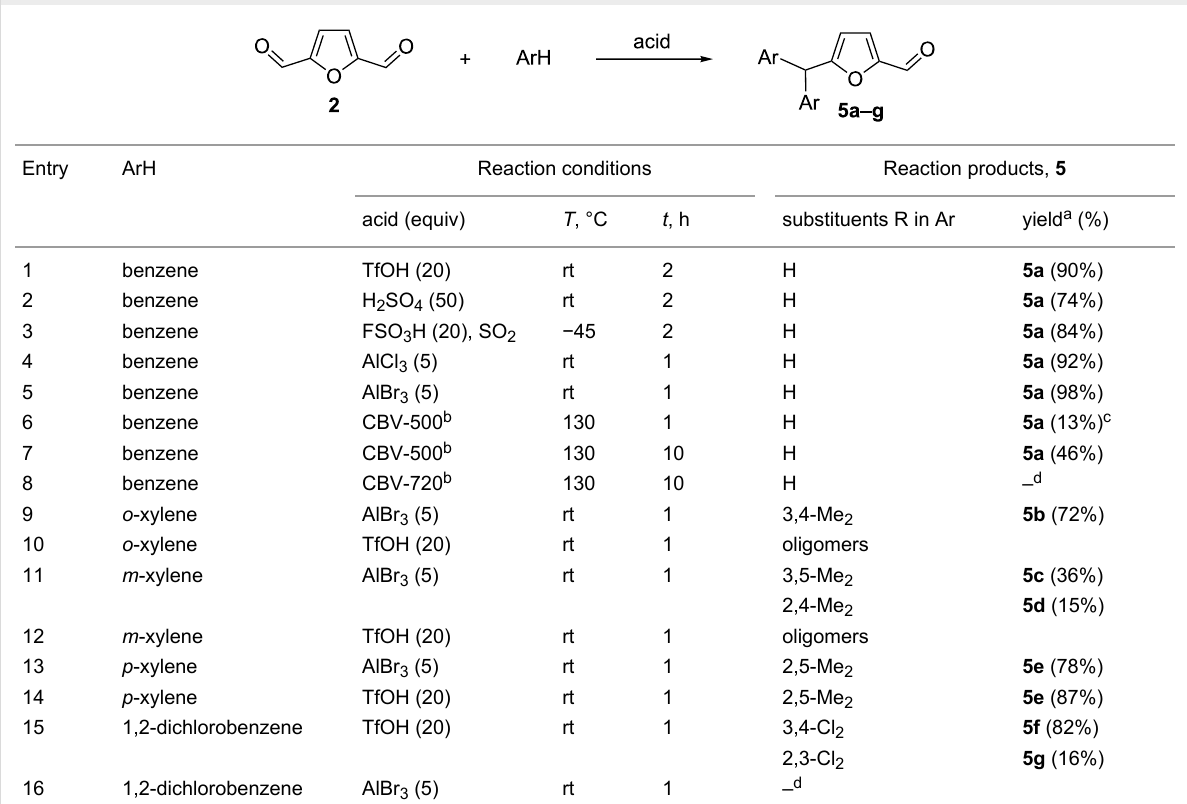
Table 5: Reactions of 2,5-DFF 2 with arenes under the action of various acids.